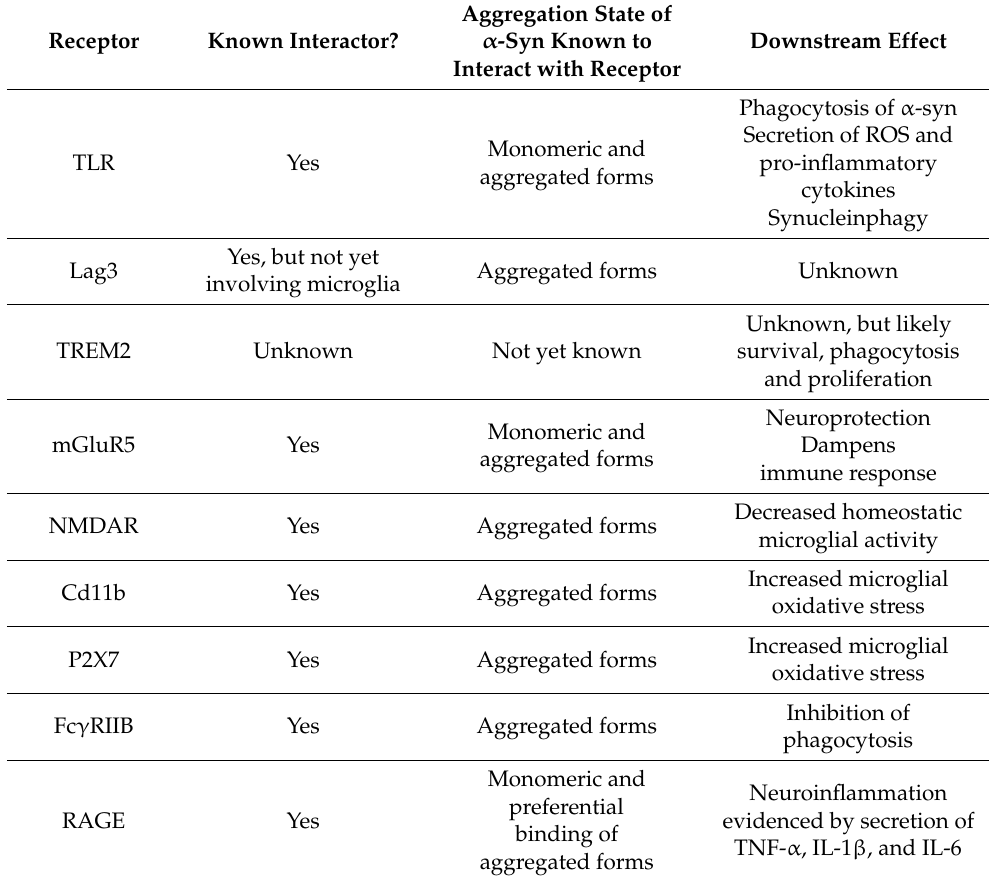
Table 2. Summary of important α -syn receptors in microglia for future investigation. Compilation of the receptors described in this review, the form of α -syn they bind to, and any known downstream effects. Aggregation State of α -Syn Known to Receptor Known Interactor? Downstream Effect Interact with Receptor Phagocytosis of α -syn Secretion of ROS and Monomeric and pro-inflammatory TLR Yes aggregated forms cytokines Synucleinphagy Yes, but not yet Aggregated forms Unknown Lag3 involving microglia Unknown, but likely TREM2 Unknown Not yet known survival, phagocytosis and proliferation Neuroprotection Monomeric and Dampens mGluR5 Yes aggregated forms immune response Decreased homeostatic NMDAR Yes Aggregated forms microglial activity Increased microglial Cd11b Yes Aggregated forms oxidative stress Increased microglial P2X7 Yes Aggregated forms oxidative stress Inhibition of Fc γ RIIB Yes Aggregated forms phagocytosis Monomeric and Neuroinflammation preferential RAGE Yes evidenced by secretion of binding of TNF- α , IL-1 β , and aggregated forms